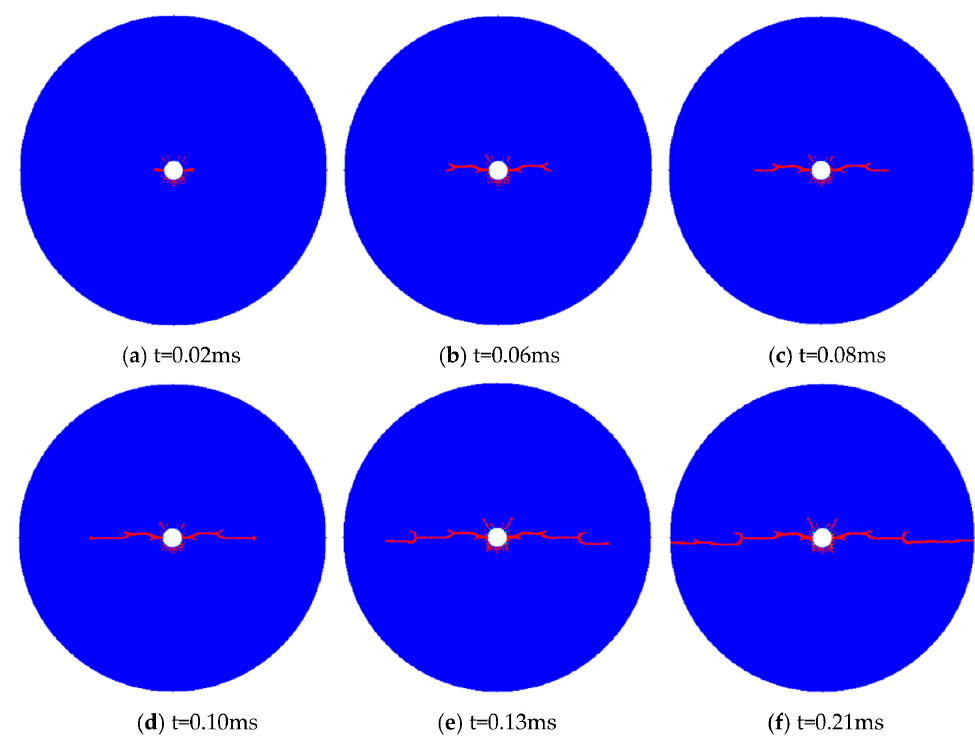
Figure 21. Development process of crack initiation by single-hole shaped charge blasting.